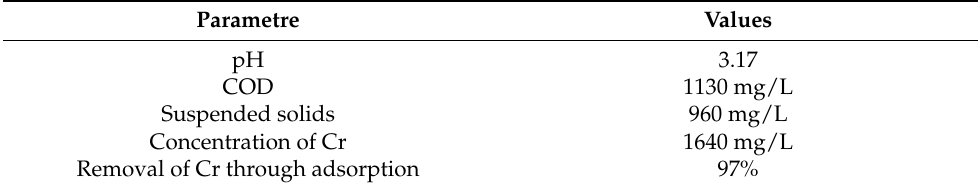
Table 6. Characteristics of tannery wastewater and removal of